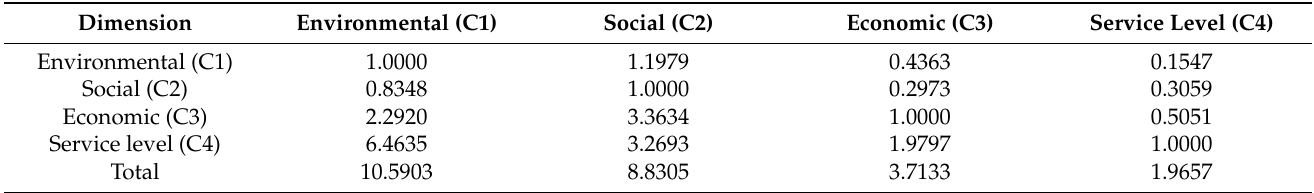
Table 6. The crisp matrix of G-AHP.